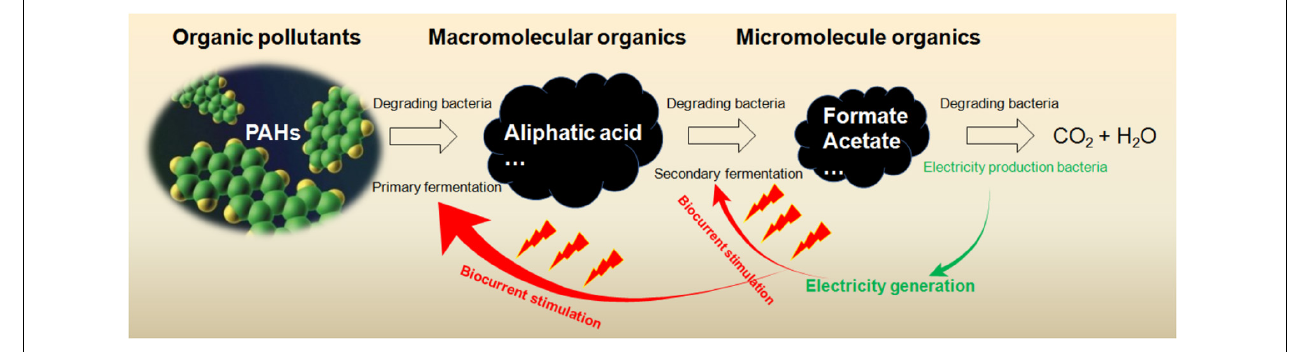
FIGURE 4 | PAH degradation processes involving diversified